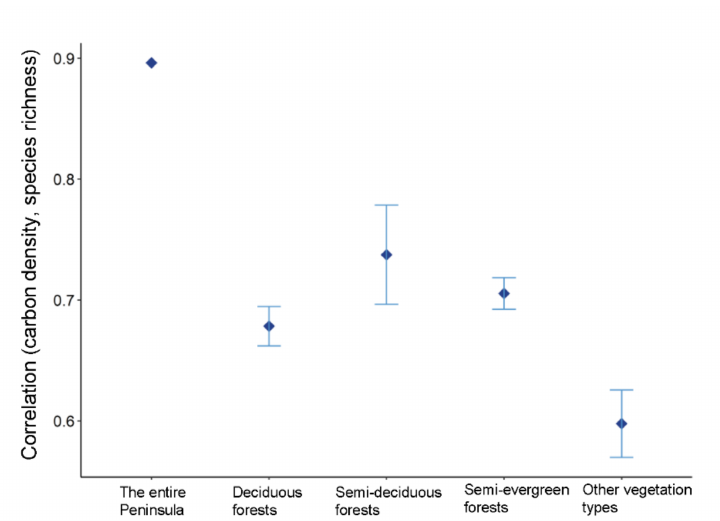
Figure 9. Correlation between carbon density and species richness for the entire peninsula and for different vegetation types: deciduous, semi-deciduous and semi-evergreen tropical dry forest forests and other vegetation types (mangrove forest, natural grasslands with some trees and wetlands). The diamonds represent the mean values and the lines 95% confidence